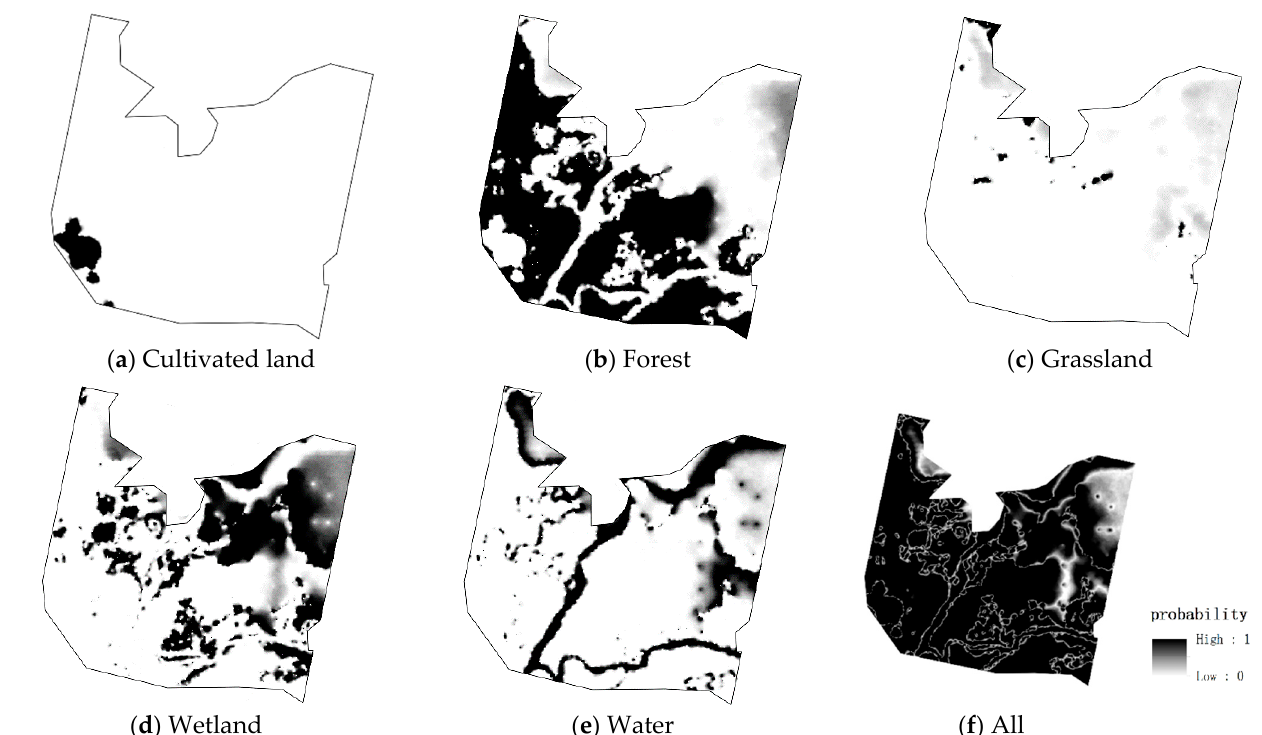
Figure 8. Occurrence probability map results of auxiliary data added.